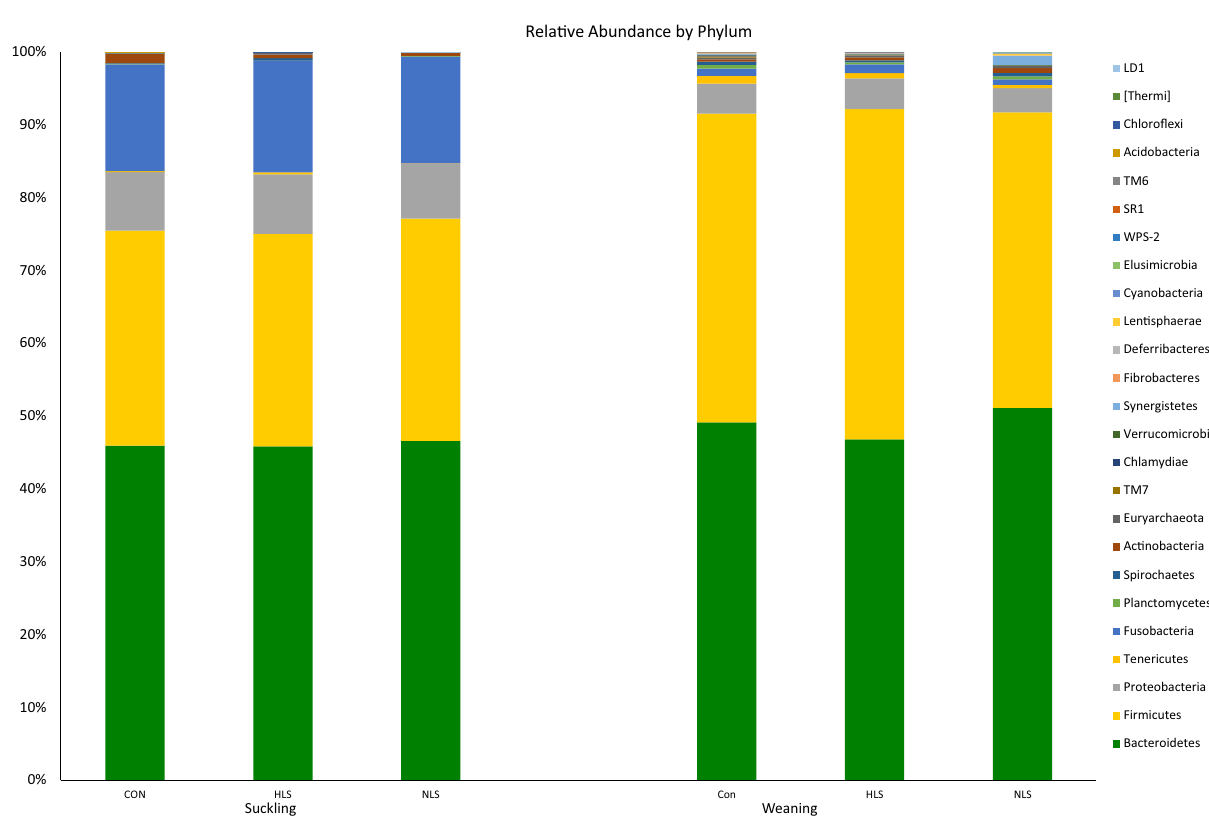
Figure 5. 16S rRNA gene analysis revealed the relative abundance of fecal bacterial community structure at the phylum level in piglets orally treated with probiotics Lactobacillus salivarius 144 (HLS), L. salivarius 160 (NLS), or without probiotic (CON) at suckling (d 4) and weaning (d 21)